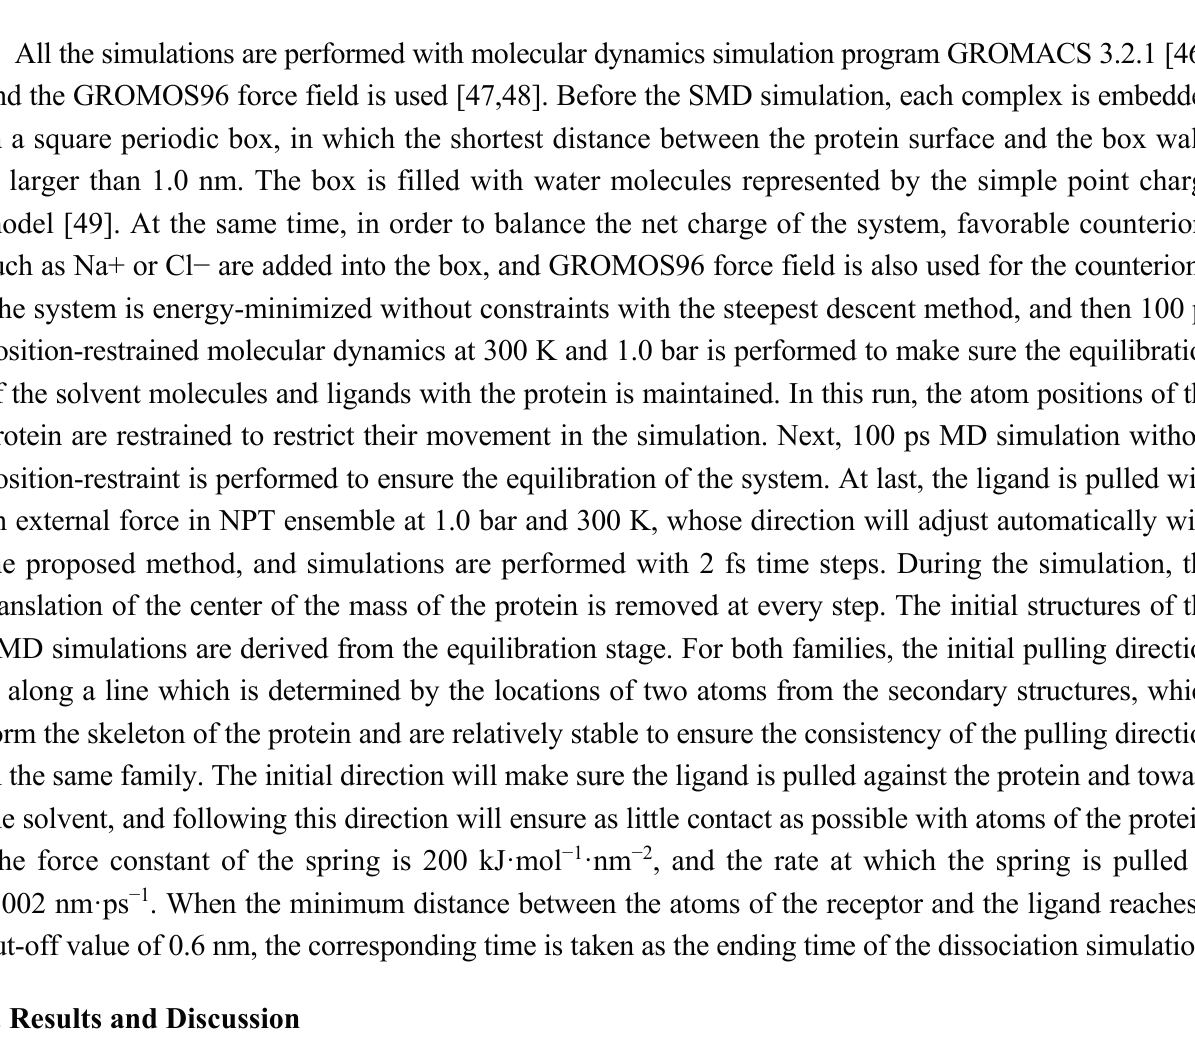
Figure 1. The ligand structural formulas of the complexes in the two families: ( A ) HIV-1 protease and ( B ) Tyrosine-protein